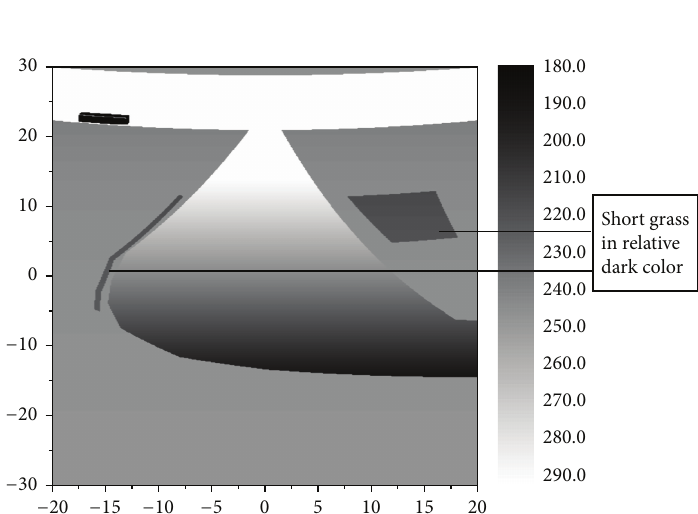
Figure 12: Revised simulated image of improved